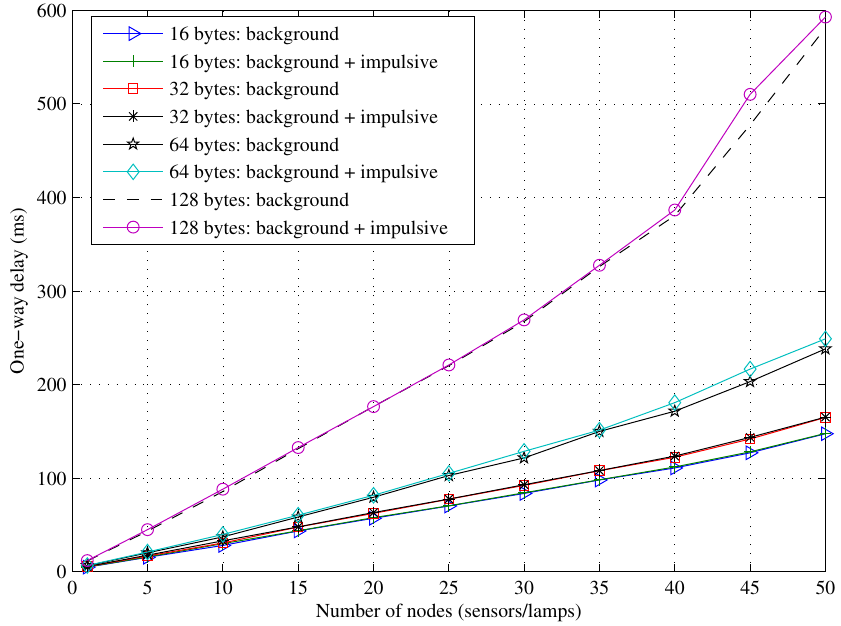
Figure 11. Effect of impulsive noise on one-way